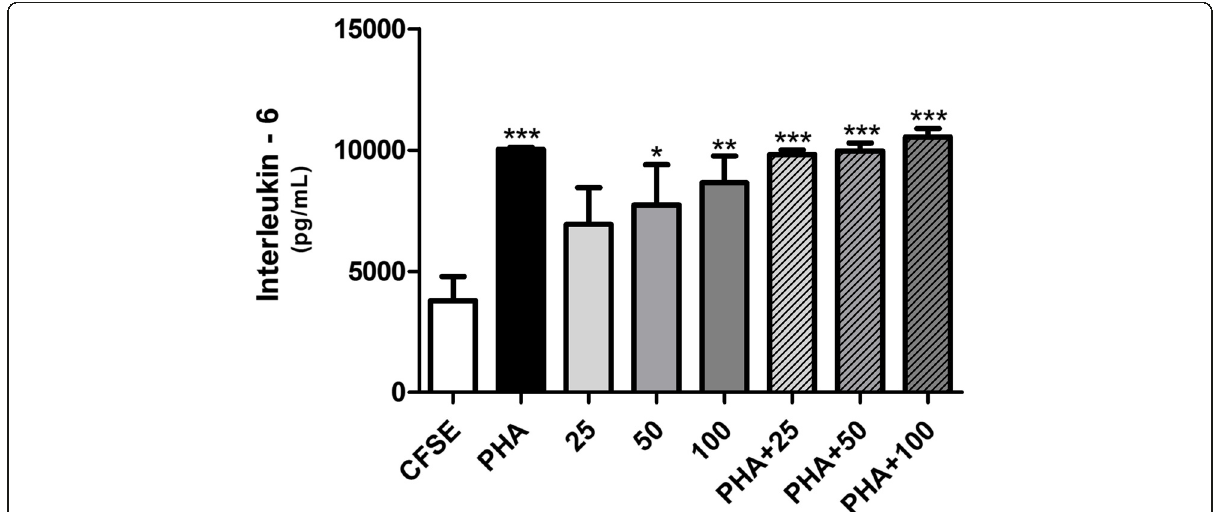
Fig. 4 Interleukin-6 (IL-6) release by PBMC treated with Tityus serrulatus scorpion venom (TsV) for 96 h. Peripheral blood mononuclear cells (PBMC; 5.0 × 10 5 cells) were labeled with carboxyfluorescein diacetate succinimidyl ester (CFSE; 2.5 μ M) and cultured with TsV (25, 50, and 100 μ g/mL) alone or in combination with phytohemagglutinin (PHA; 2 μ g/mL) for 96 h. The levels of IL-6 in culture supernatants were determined by flow cytometry. CFSE: CFSE-stained cells cultured in RPMI 1640; PHA: PHA-stimulated cells (positive control); 25, 50, 100: cells incubated with 25, 50, and 100 μ g/mL TsV, respectively; PHA + 25, PHA + 50, PHA + 100: cells incubated with PHA plus 25, 50, and 100 μ g/mL TsV, respectively. Each column represents the mean ± SEM of five experiments. * p < 0.05, ** p < 0.01, *** p < 0.001 vs.